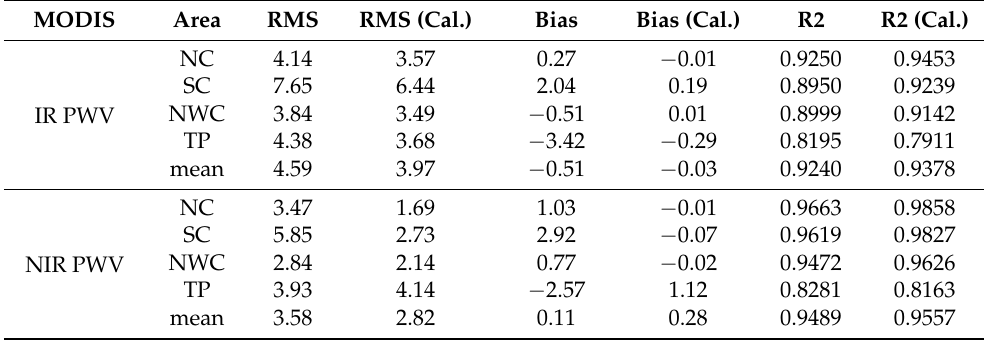
Table 8. Statistical results of MODIS IR/NIR PWV products with and without calibration for 964 grid points over the period 2011–2017. MODIS Area RMS RMS (Cal.) Bias Bias (Cal.) R2 R2